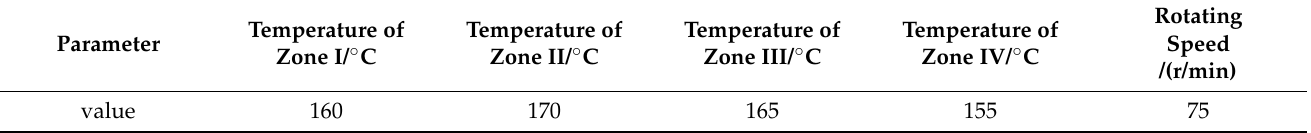
Table 3. Twin-screw extruder process parameters.